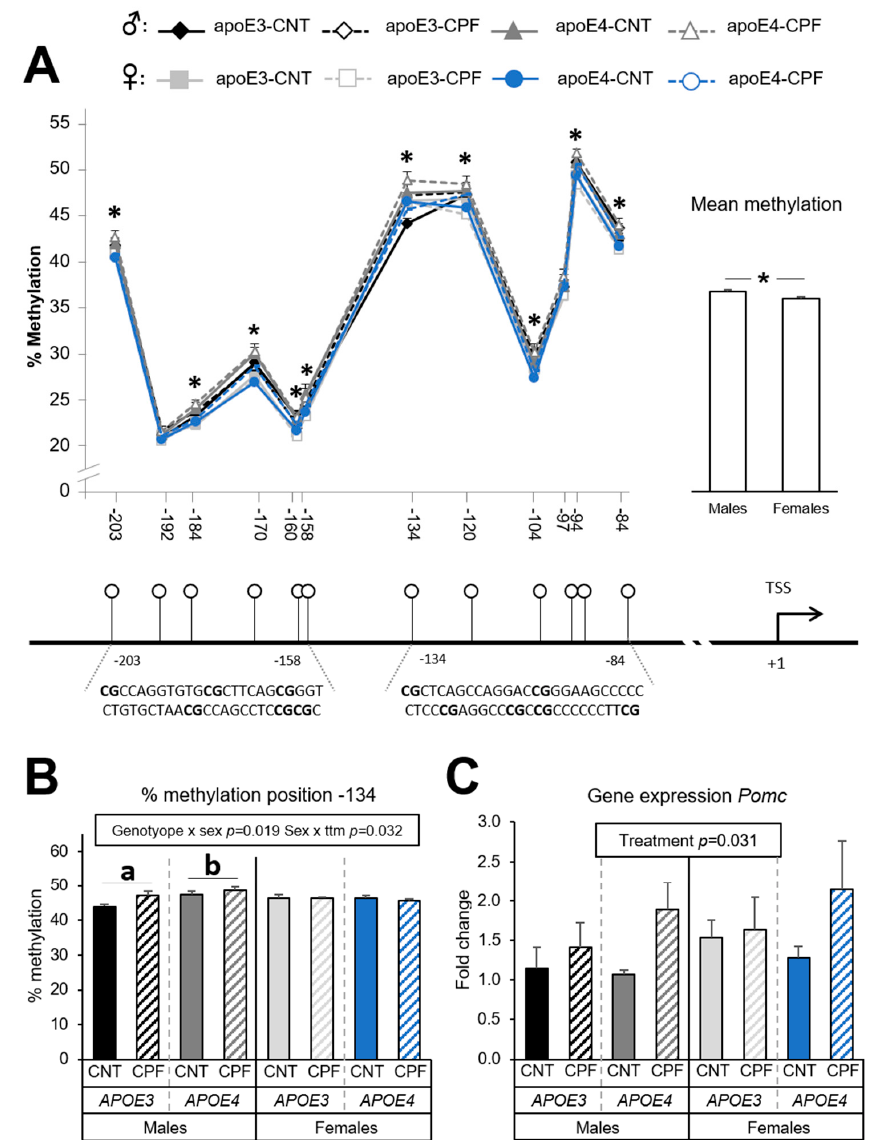
Figure 2. Pomc gene methylation at the CpG positions studied in the target zone in the promoter and overall methylation levels, which are sharing the same y axis. Below, there is the graphical representation of the CpG positions studied and the exact sequence of the target region ( A ). Methylation at the specific position − 134 ( B ) and gene expression of the Pomc gene ( C ). All groups included 6 animals except for the APOE3 -CNT that included 5. An asterisk (*) indicates significant differences between groups at p < 0.05. Abbreviations: CNT, control; CPF, chlorpyrifos-treated; ttm, treatment. Data is contained within the Supplementary File S1.